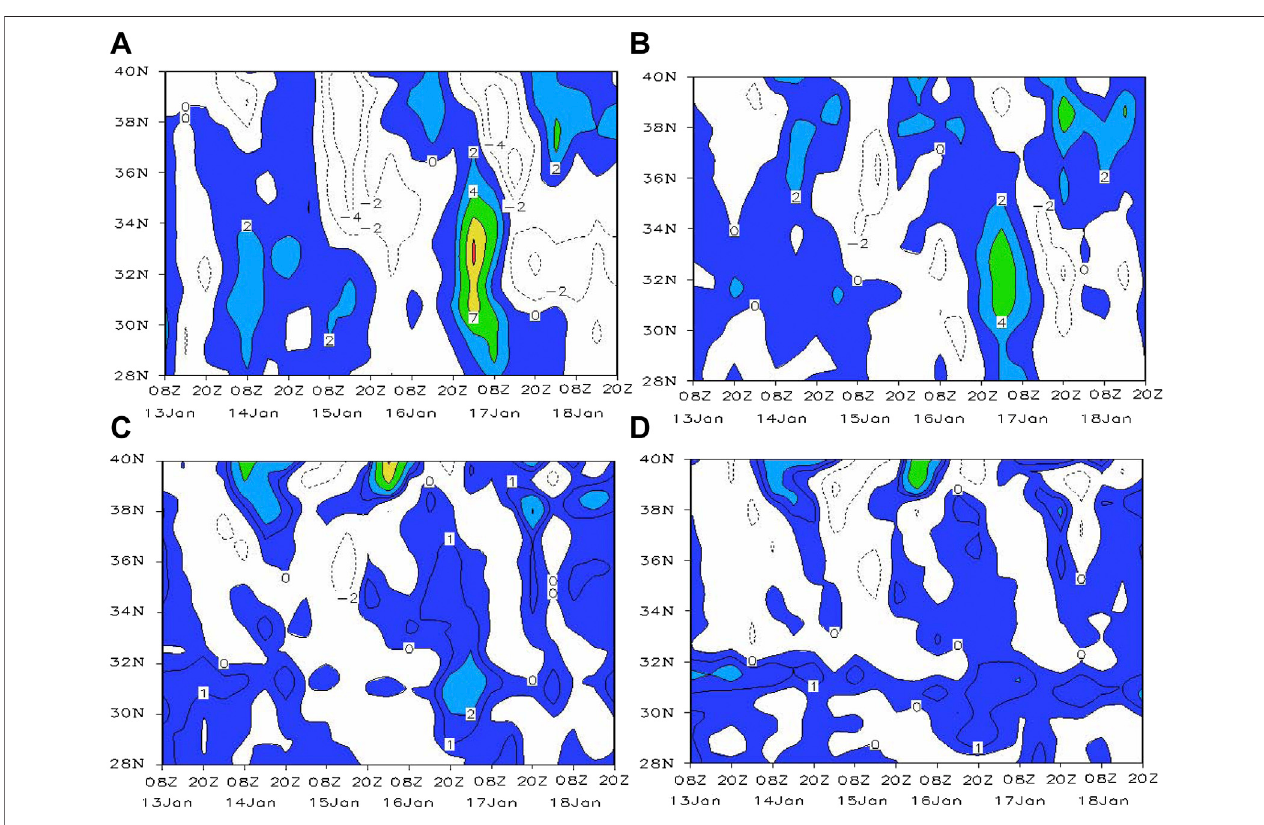
FIGURE 9 | Vertical velocity distributions at 115.75E (A) 500 hPa; (B) 700 hPa; (C) 850 hPa; (D) 925 hPa; unit: 0.1